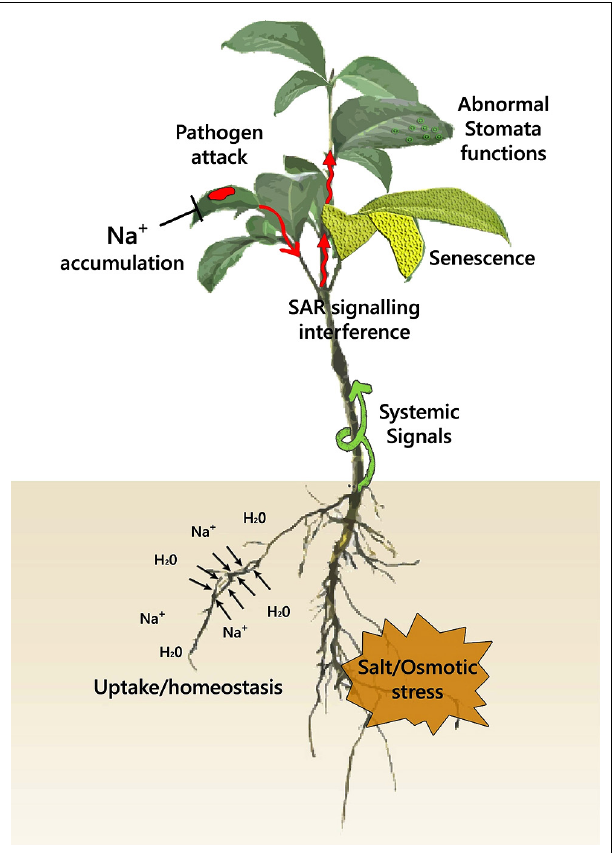
FIGURE 2 |A scheme for the effects of abiotic and biotic stress at the plant level. A combination of abiotic stress with pathogen infection potentially derails hormone and systemic ROS homeostasis. Pathogen infection has been shown to impair stomata closure under non-stress conditions, with the dynamics of this interaction under abiotic stress being unknown. Senescence is a common component of both abiotic and biotic stress that can potentially be amplified under combinatorial stress. Systemic ROS signals generated after pathogen encounter may alter water relation and salt uptake through their effects in root hydraulic conductance and ion transport. Abiotic stress through ABA signaling negatively affects signals that trigger systemic acquired resistance, enhancing pathogen spread from the initial site of infection. Ion accumulation (Na + , Cl − ) under salt stress can have a direct toxic effect on pathogen